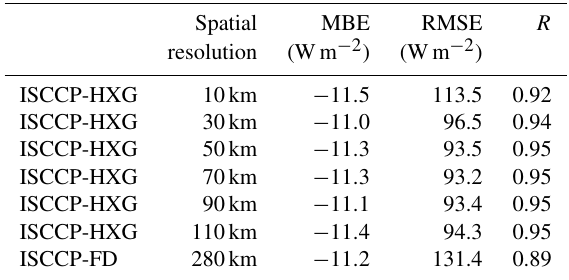
Table 1. Effect of spatial resolution on accuracy of our estimated instantaneous SSR compared to observations at the 42 BSRN sta- tions. A comparison with instantaneous SSR of ISCCP-FD is also shown.